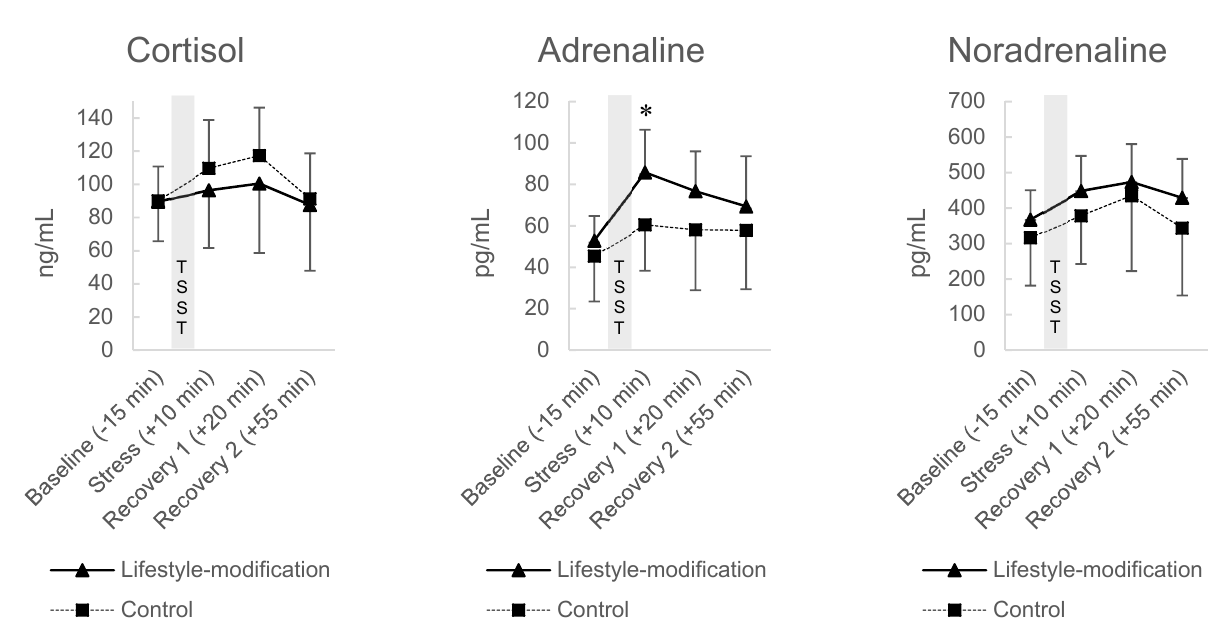
Figure 2. Results of the exploratory sub-study: Blood cell counts and hormonal blood levels in response to the Trier Social Stress Test in the comprehensive lifestyle-modification group ( n = 8) and controls ( n = 8). Values expressed as mean ± standard deviation. * p < 0.05; † p < 0.10.